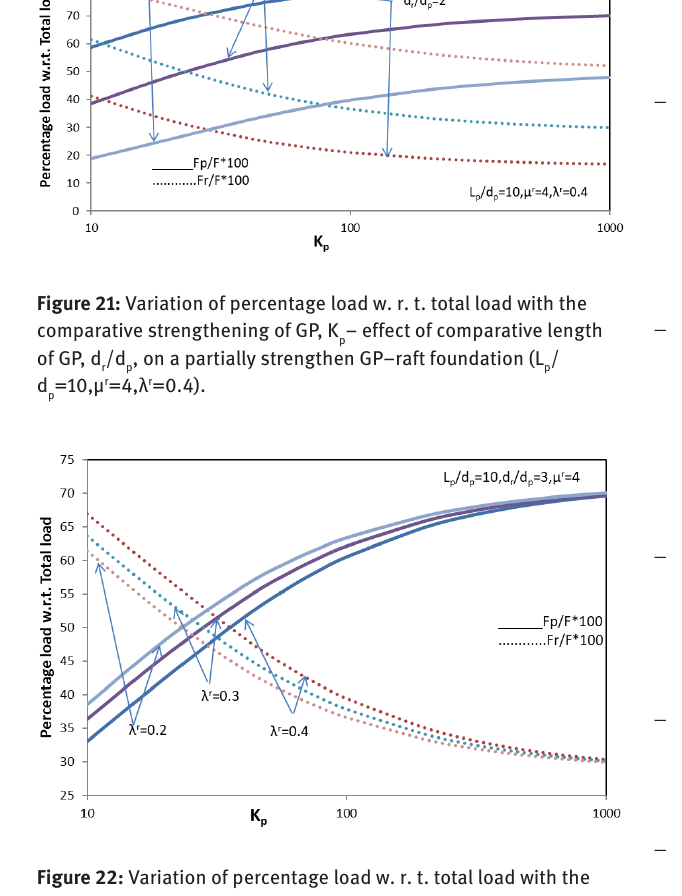
– effect of comparative length of p